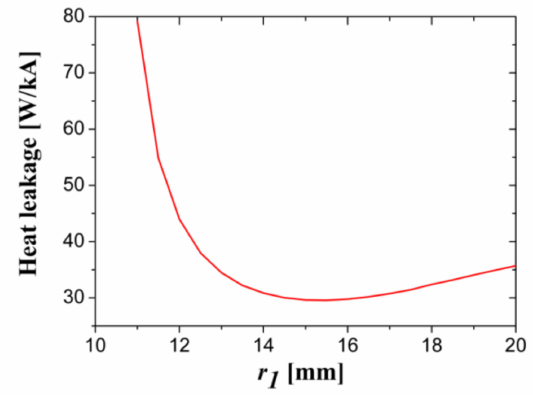
Figure A12. Iteration step three: the effect of radius of the copper leads r 1 on the cold end heat leakage of PCLs (keeping parameters L 1 = 10.0 mm, L 3 = 1700.0 mm, r 2 = 20.0 mm, L 2 = 3.5 mm unchanged; in this iteration Q min = 29.6 W/kA).